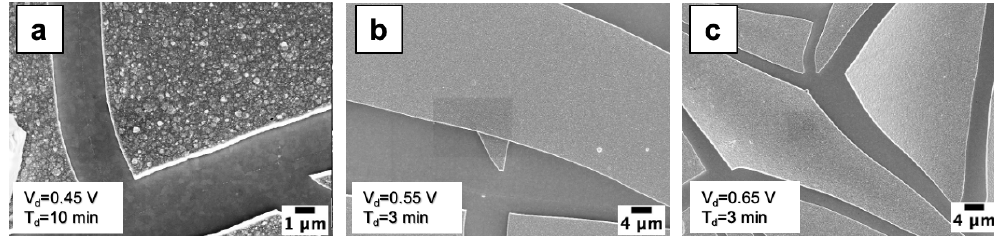
Figure 3. SEM images of electrodeposited WO 3 by using: ( a ) V d = 0.45 V and t d = 10 min; ( b ) V d = 0.55 V and t d = 3 min; ( c ) V d = 0.65 V and t d = 3 min.